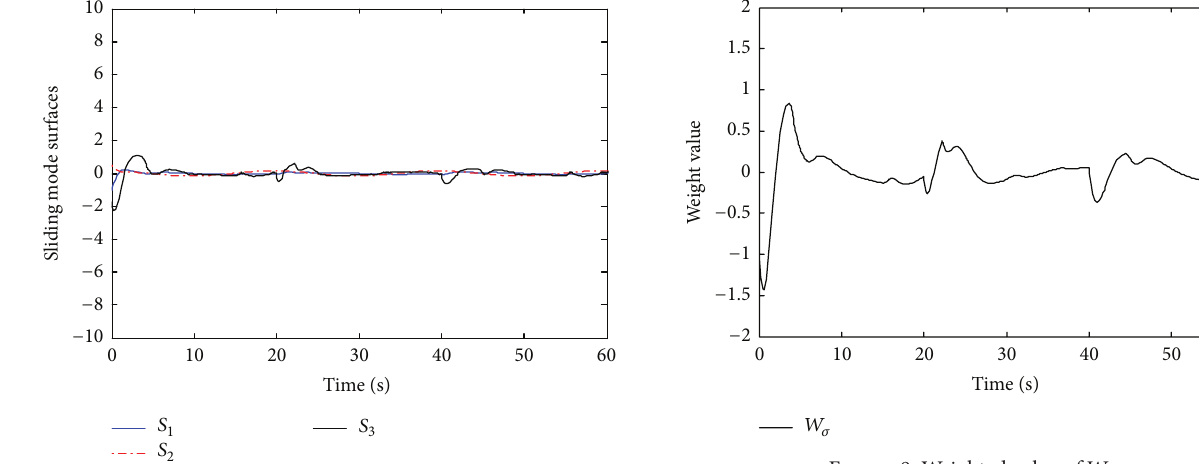
Figure 9: Weighted value of 𝑊 𝜎 .